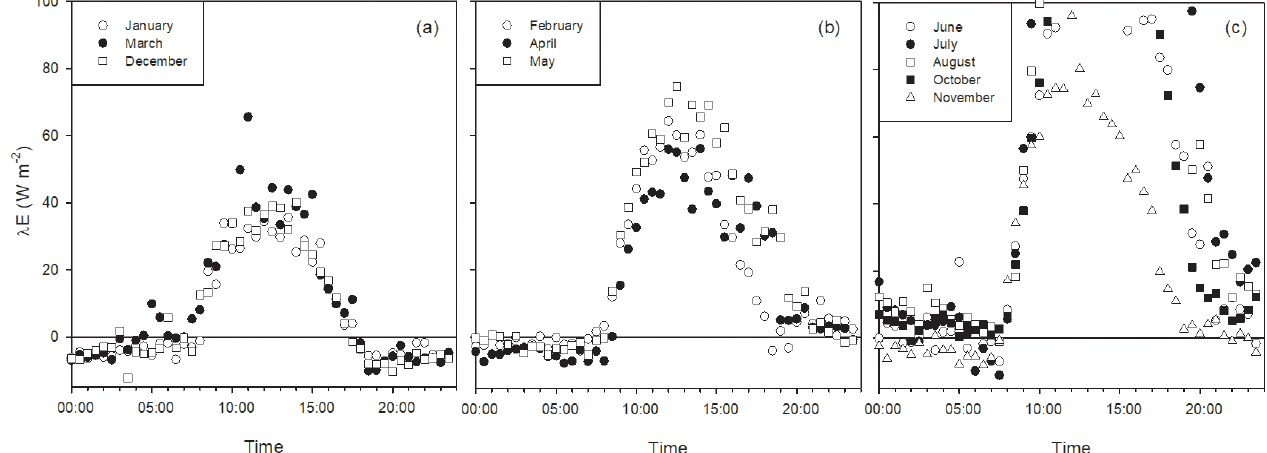
Figure 6. Latent heat flux daily trend at Bernal during different months, emphasizing nighttime λE . Panel (a) shows months with low rainfall in the previous month and predominantly negative λE during nighttime (these months had low rainfall: 0.17, 11.3 and 0.33mm rainfall for January, March and December). Panel (b) shows months with low rainfall in the previous month and positive λE after sunset (6.7, 7.3 and 20.7mm rainfall for February, April and May). Panel (c) shows months during the rainy season with positive λE mainly due to soil wetness and antecedent rainfall of 43, 202, 9, 190 and 34mm for June, July, August, October and November. Plot (c) is out of scale on the y axis for compatibility with the other plots.